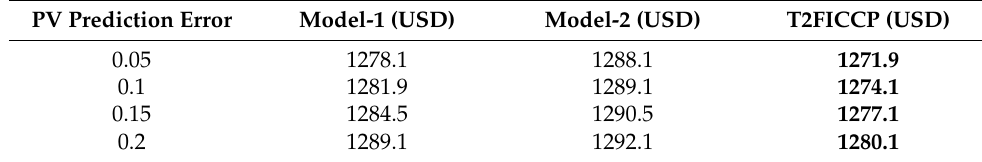
Table 4. Scheduling costs for different PV prediction errors ( β = 0.95, constant load prediction